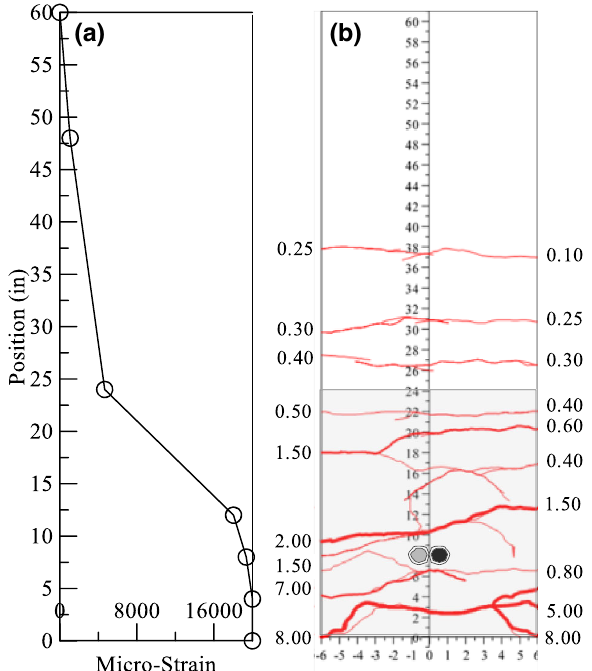
Fig. 7 Strain in a longitudinal bar and crack map of Specimen S1 column at 8 D y (Crack width in mm; 1 in. = 25.4 mm). a Strains in longitudinal bars and b crack map (crack widths shown on the side of